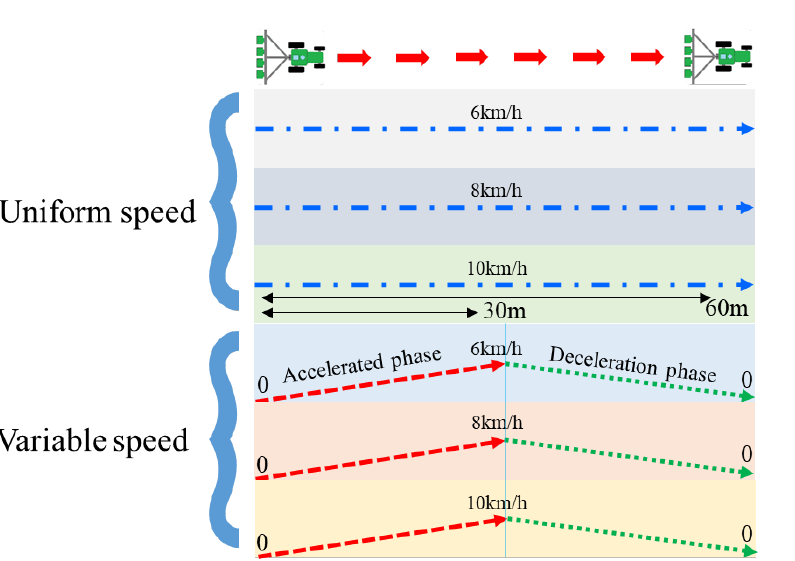
Figure 10. Seeder and monitoring system.